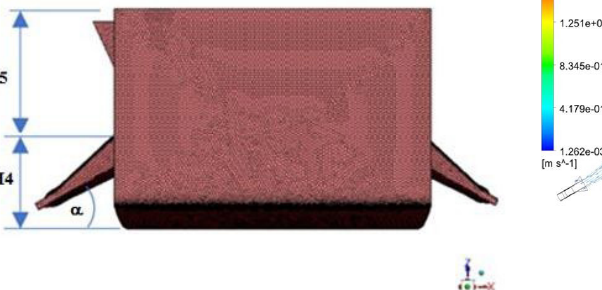
Figure 6. Flow pattern of the zinc bath in the galvanizing pot in a sectional plane showing the pot and the two inductors in the